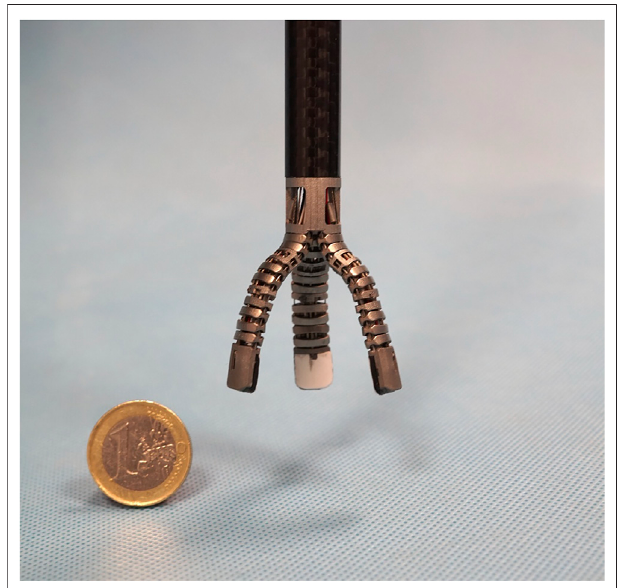
FIGURE 1 | The MUSHA